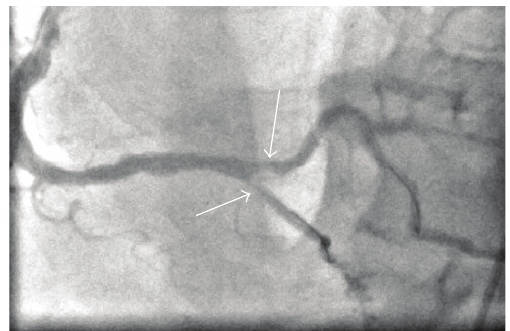
Figure 1: Angiogram showing 90% occlusion of PDA (left arrow) and 70% of distal RCA (right